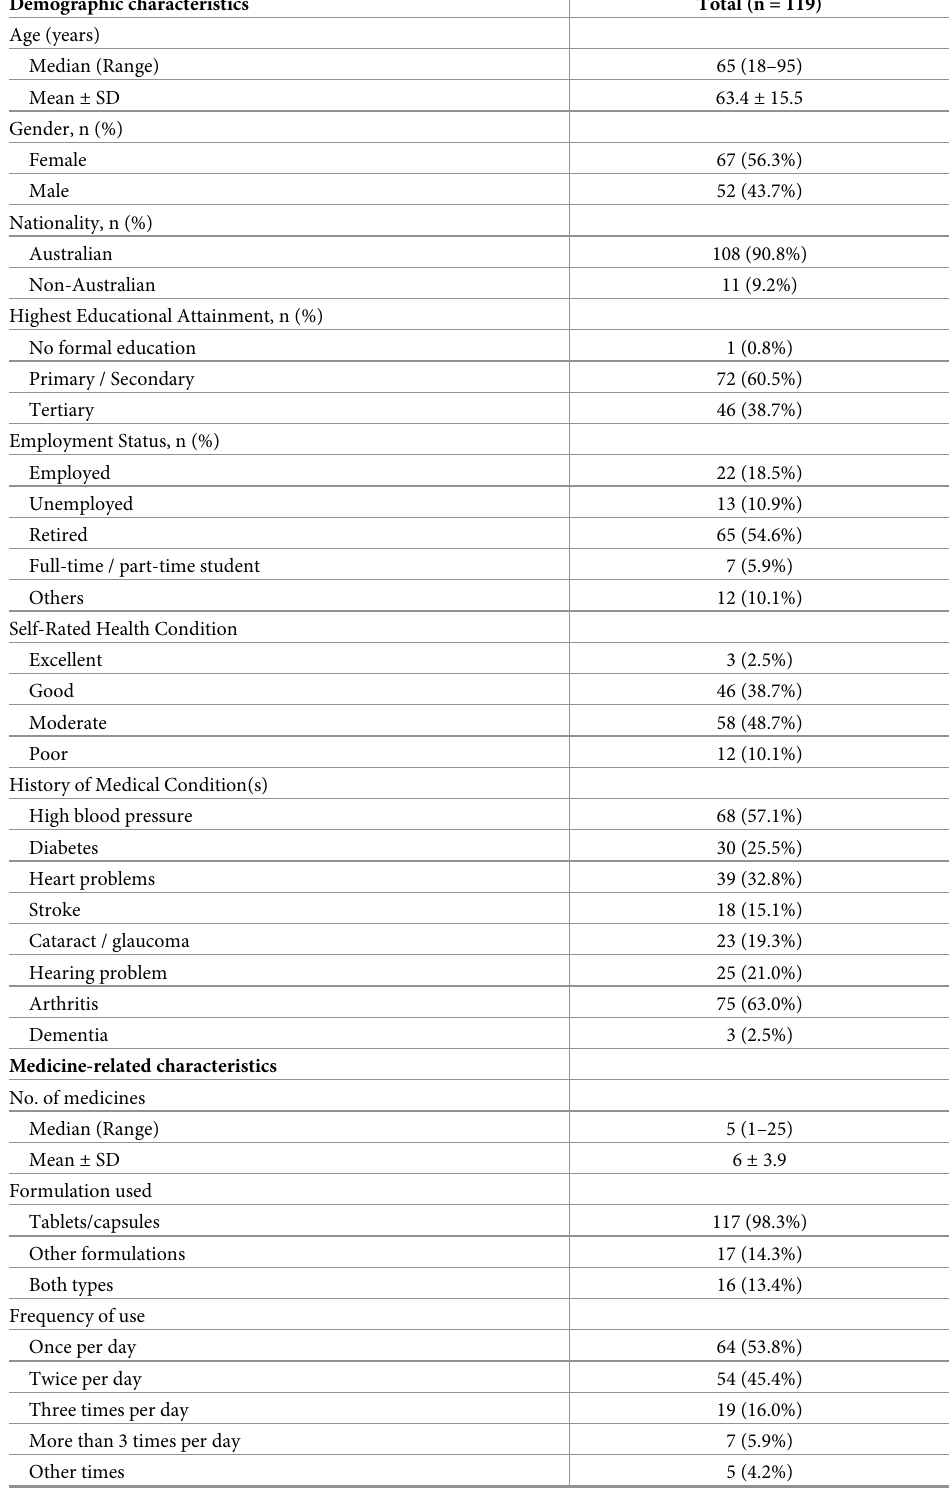
Table 1. Demographic and medicine-related characteristics (n =